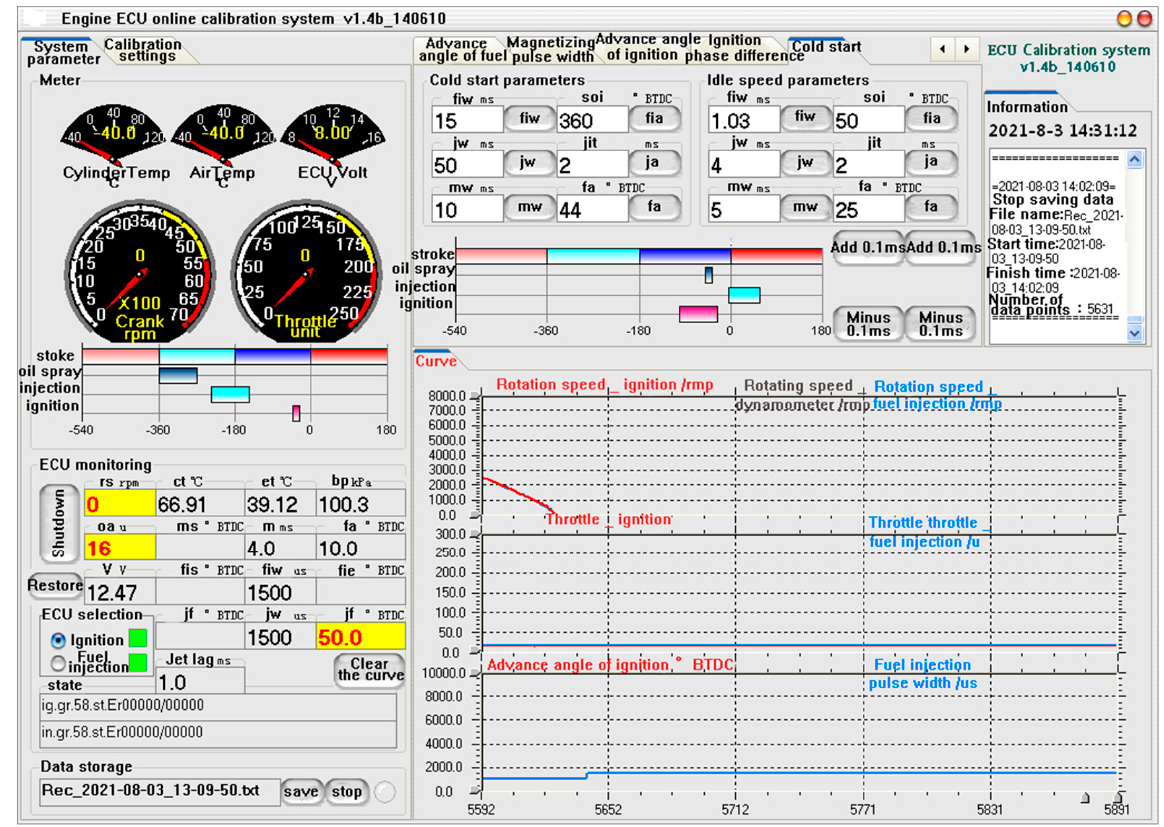
Figure 6. Control software interface.